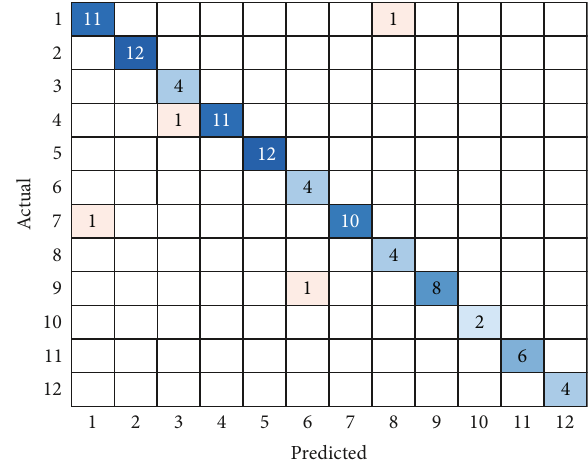
Figure 14: Confusion matrix of labels predicted by BiLSTM model and actual labels as marked in the